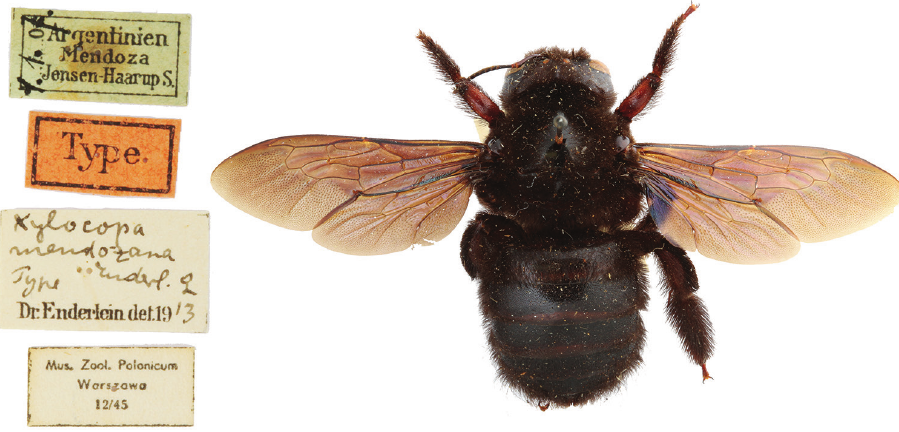
Figure 6. Dorsal habitus of the female lectotype of Xylocopa ( Neoxylocopa ) mendozana Enderlein. mendozana Enderlein des. M. Lucia & V.H. Gonzalez. This specimen as well as the others are currently in USNM.